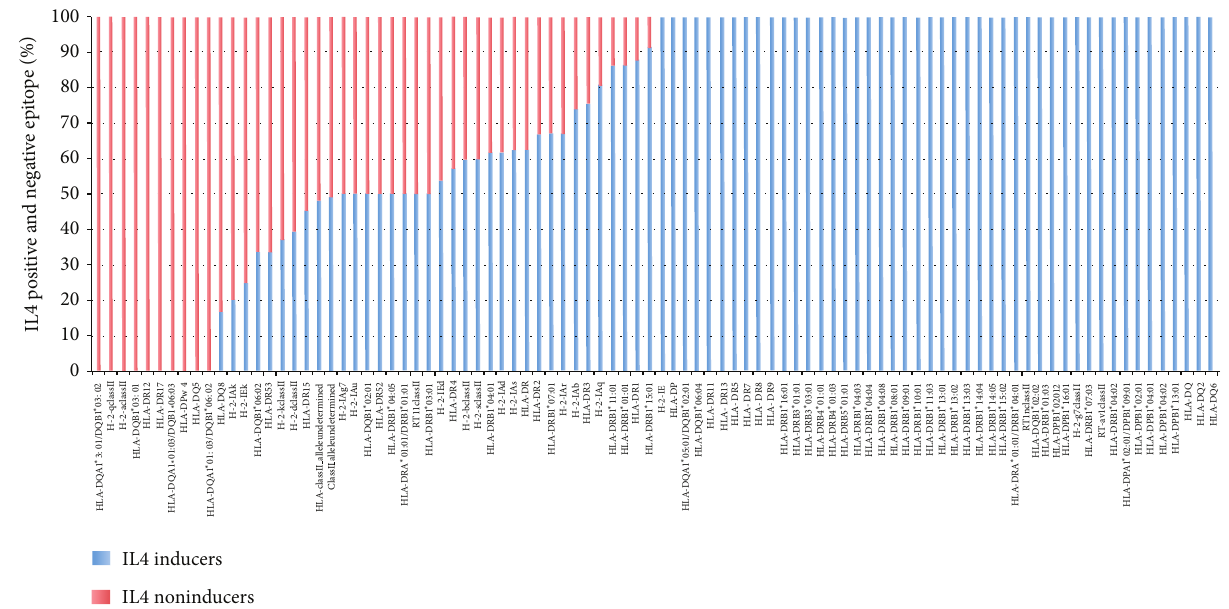
Figure 3: Representing the percentage bar plot of IL4 positive and IL4 negative epitope with corresponding MHC alleles.